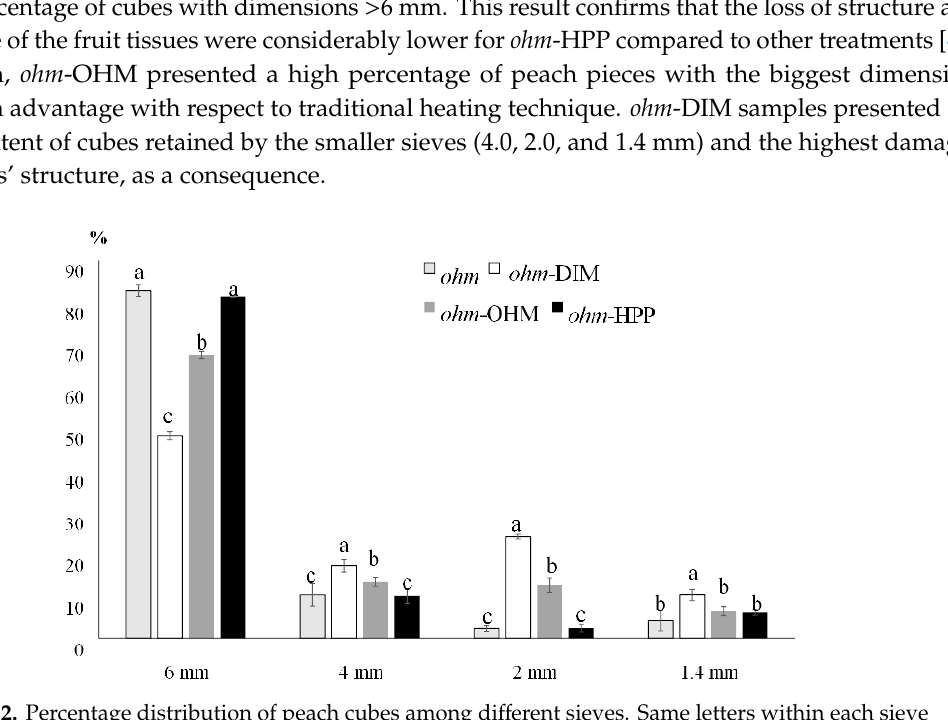
Figure 2. Percentage distribution of peach cubes among different sieves. Same letters within each sieve do not significantly differ (n = 3; p < 0.05).